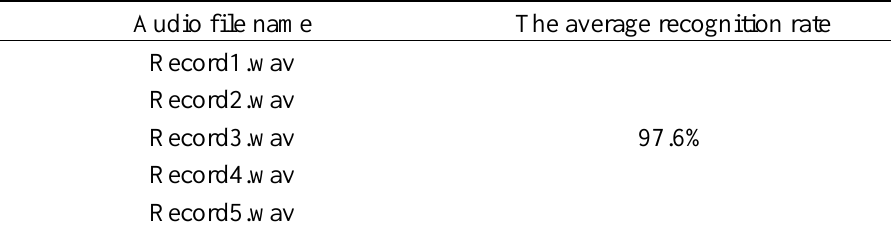
Table 12. Asthmatics analysis results for the clinical asthmatics.